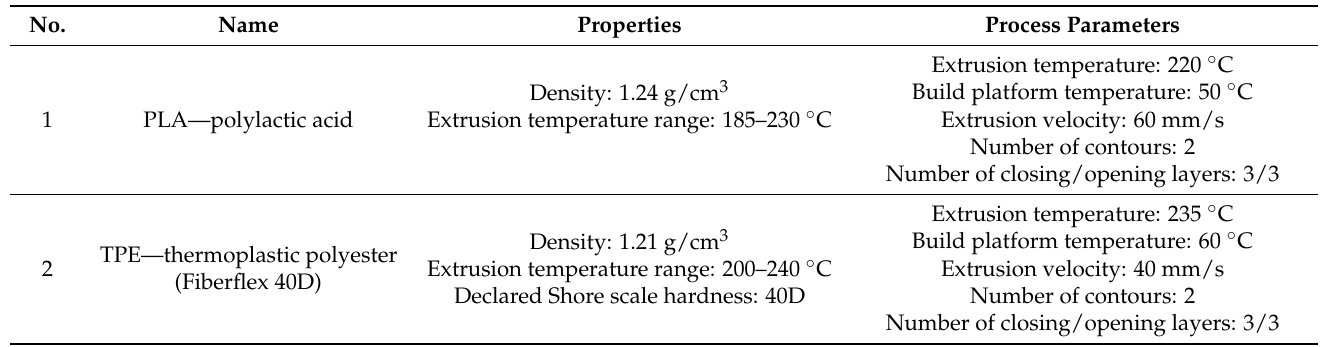
Table 1. Characteristics of materials used and FDM process